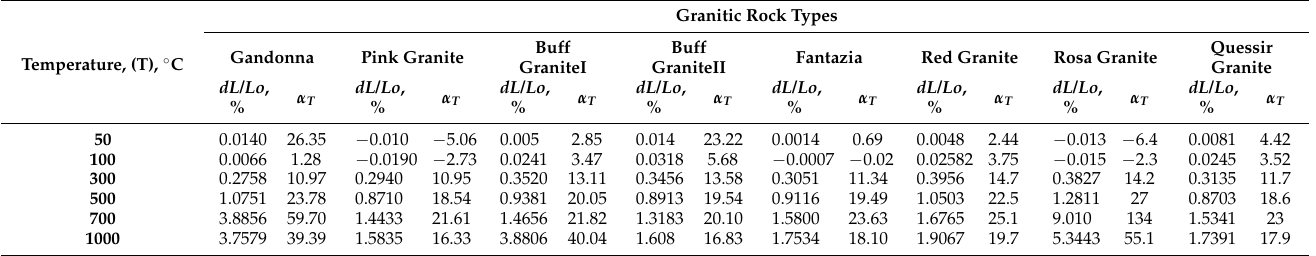
Table 4. Measurements of ( dL / Lo , %) and ( α T , 10 − 6 /K − 1 ) for granitic rock types at different